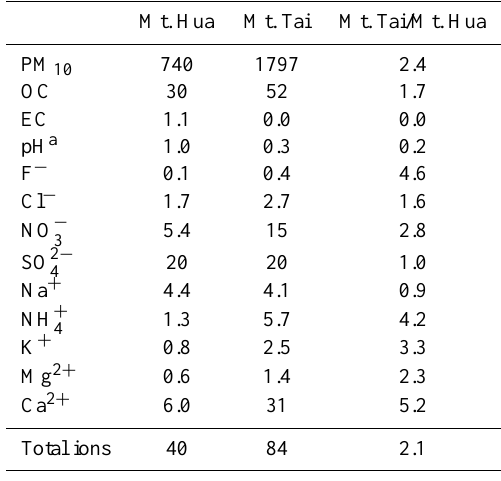
Table 4. Concentrations of species in the highest loading of 3-h PM 10 sample during the dust storm II event occurring on 24 April, µgm − 3 . Mt. Hua Mt. Tai Mt. Tai/Mt.